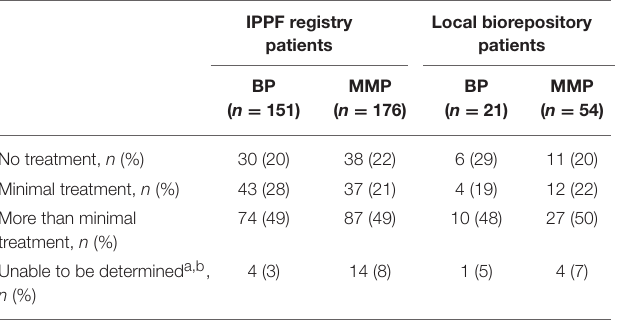
TABLE 2 | Level of treatment for IPPF registry and local biorepository patients. TABLE 3 | Medication use for IPPF registry and local biorepository